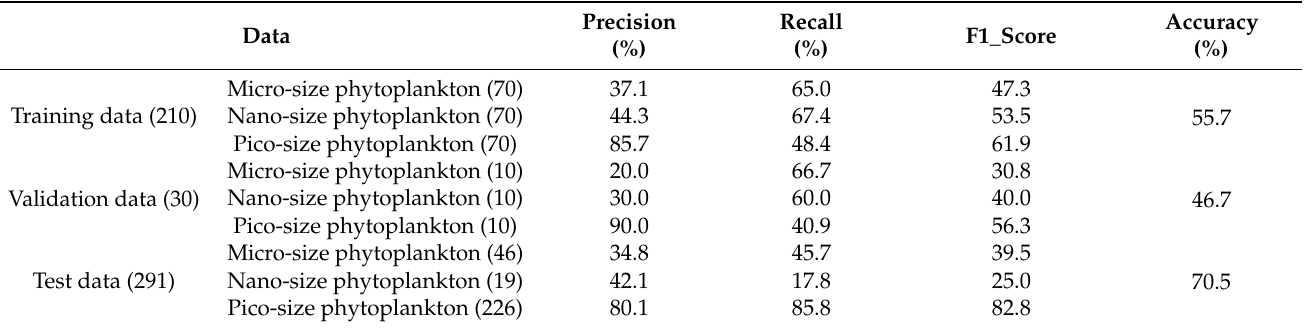
Table 3. Precision, recall, F1-score, and accuracy of training, validation, and test datasets for classifi- cation